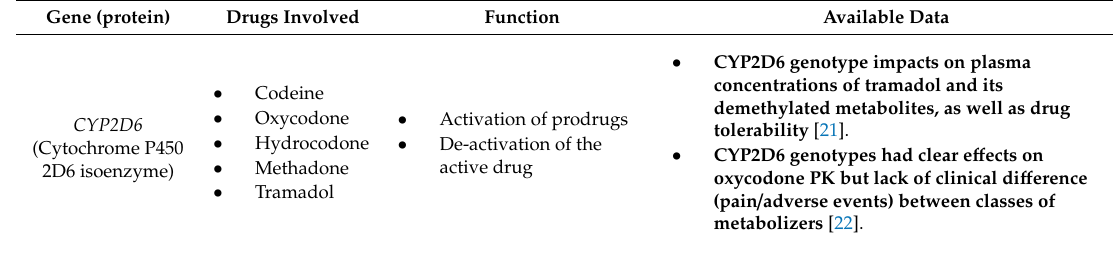
Table 2. Commonly used opioids and genetic variants reported to modulate response. Bold text refers to studies in cancer